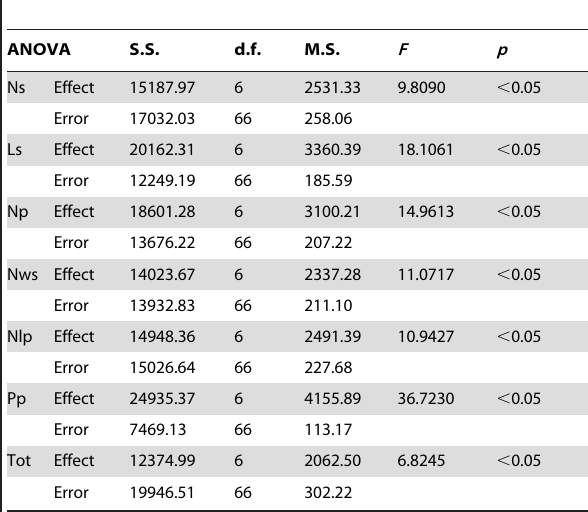
Table 2. Univariate analyses of variance with ranked data.